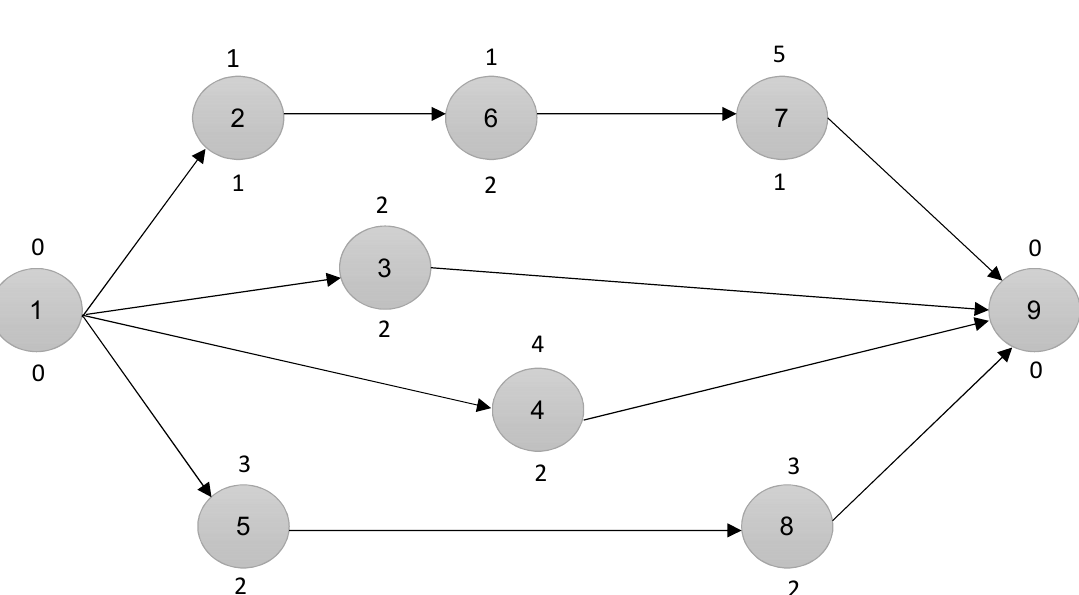
Fig. 1. Nine-activity project representation example. Source: Based on Demeulemeester and Herroelen,